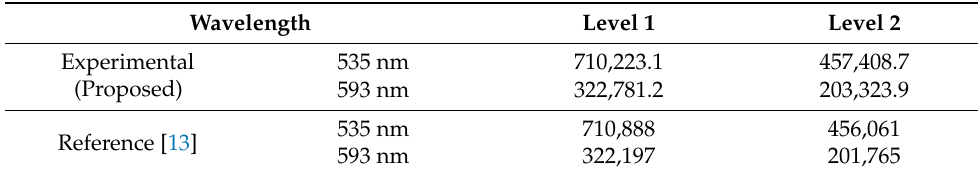
Table 3. Comparison of the measured molar absorption coefficients of HbA1c between the present study and Reference